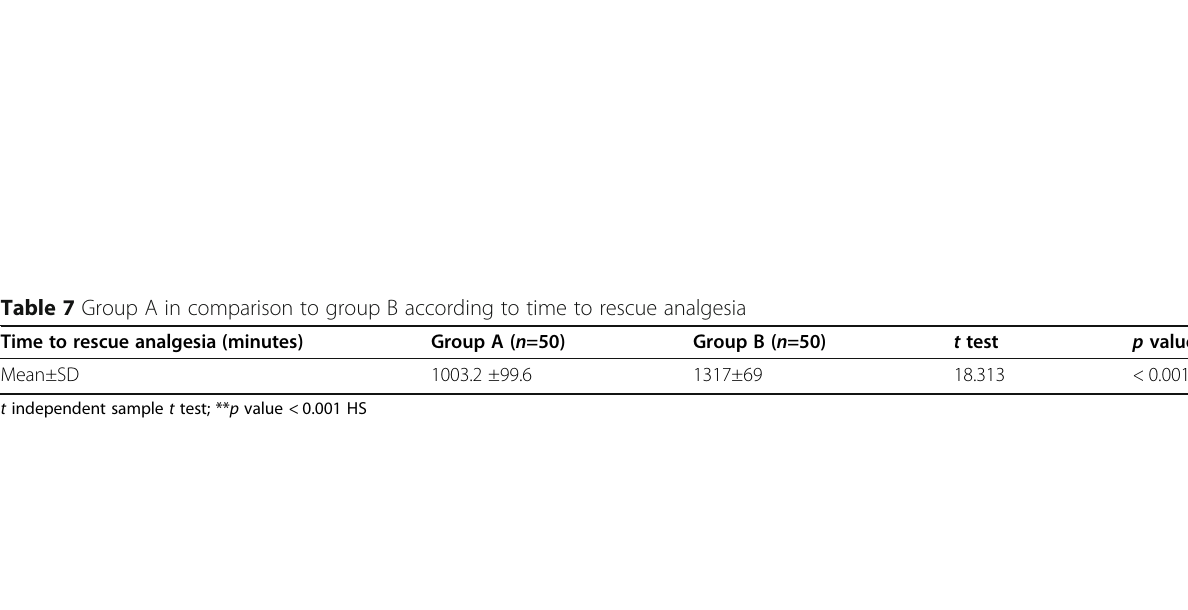
Table 6 Group A in comparison to Group B according to postoperative visual analog scale Postoperative visual analog scale Group A ( n =50) Group B ( n =50) p value At 0 h 1 (0 – 1) 1 (0 – 1) 0.544 At 4 h 1(1 – 1) 1 (0 – 1) 0.224 At 8 h 1 (1 – 1) 1 (0 – 1) 0.089 At 12 h 2 (2 – 3) 1 (1 – 2) < 0.0001 At 24 h